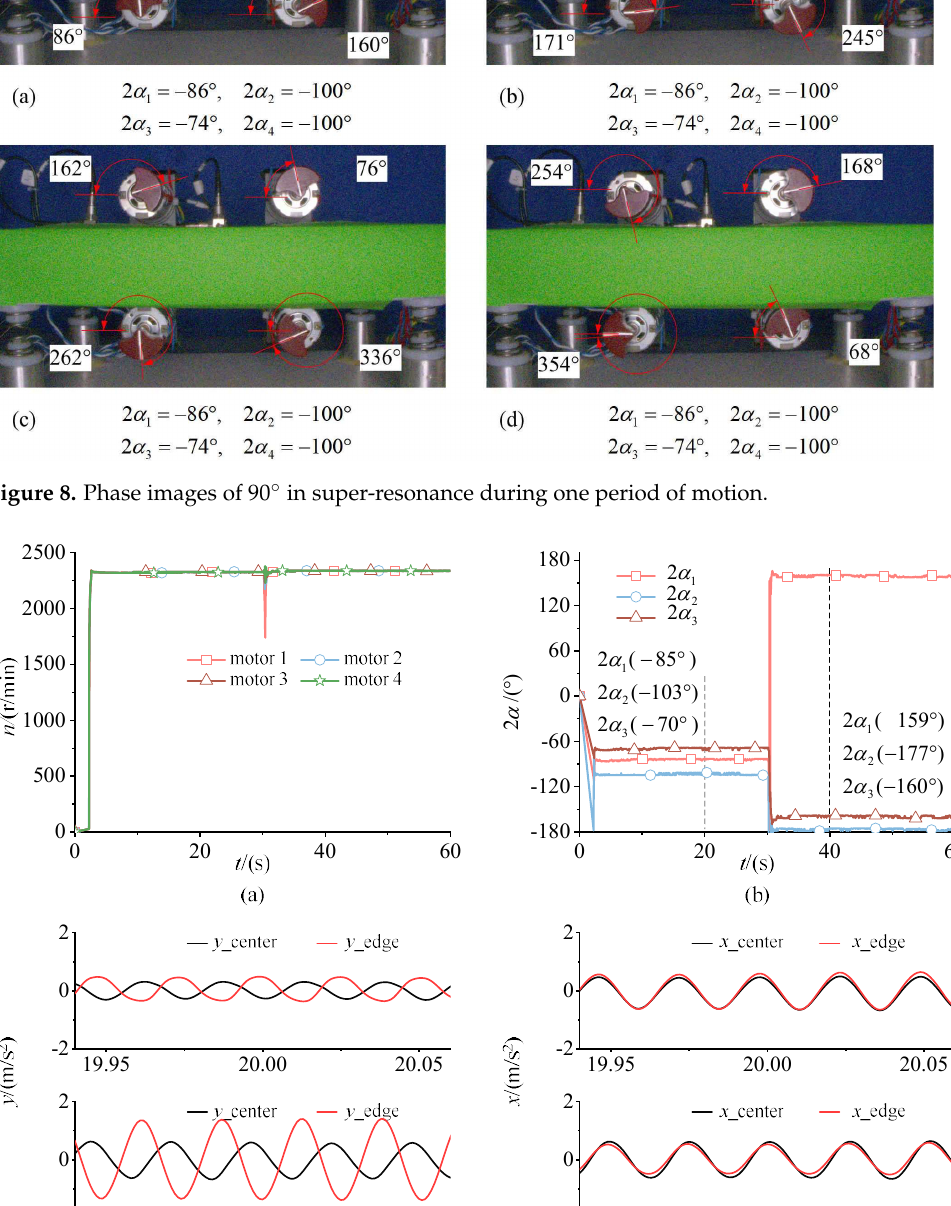
Figure 9. Phase differences of ERs change from 90 ◦ to 180 ◦ with disturbance: ( a ) Synchronous velocities of four ERs; ( b ) Phase differences; ( c ) Acceleration amplitude in y direction at 20 s and 40 s; ( d ) Acceleration amplitude in x direction at 20 s and 40 s.